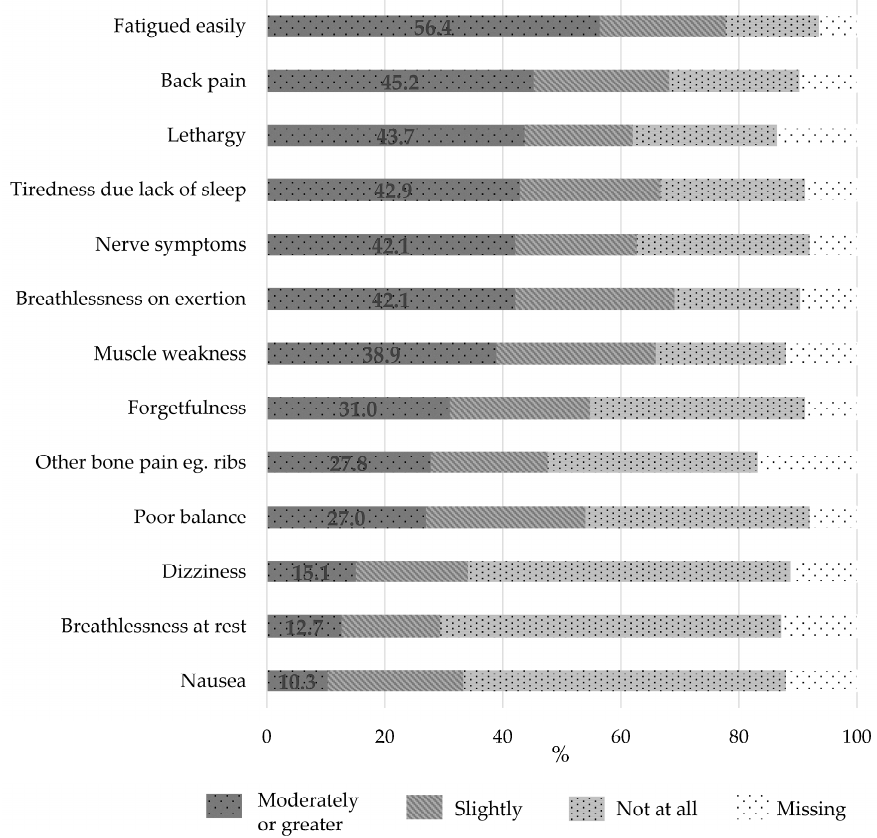
Figure 2. Intensity of symptoms experienced by people with multiple myeloma over the previous month ( n = 126).